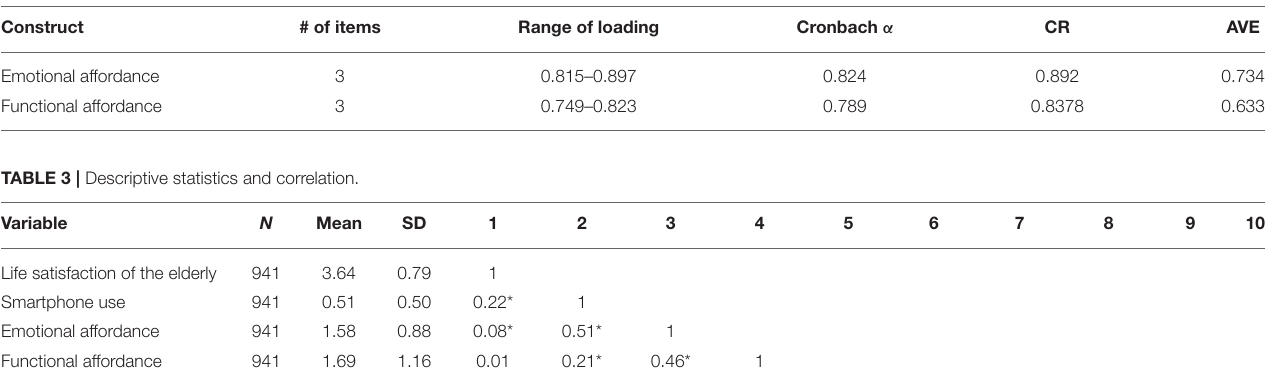
TABLE 2 | Multi-item measurement information.